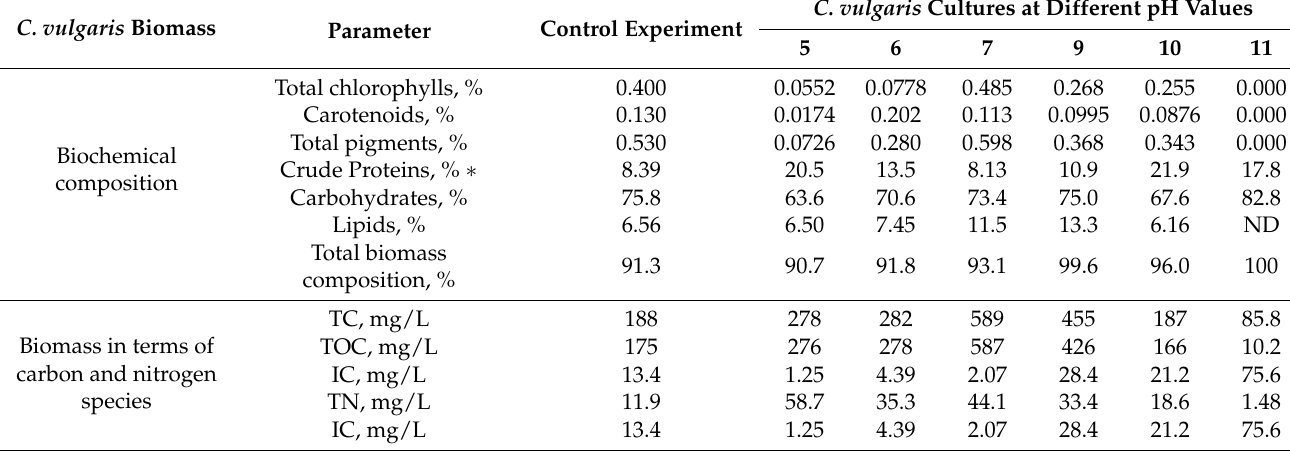
Table 2. Biochemical composition of the biomass obtained from Chlorella vulgaris growth in primary urban wastewater at various pH values and in the control experiment at pH = 9 without microalga. C. vulgaris